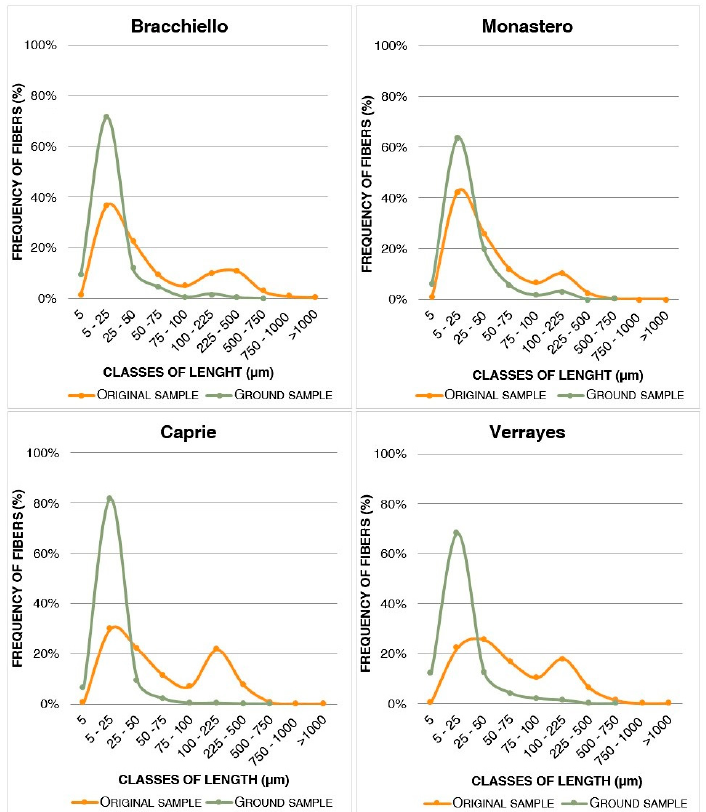
Figure 9. Percentage frequency of particles in each sample, before and after grinding. Fibers 2019 , 7 , x FOR PEER REVIEW